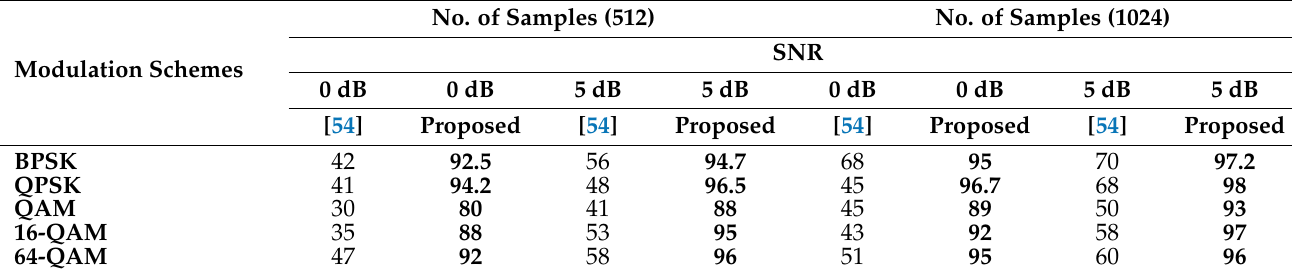
Table 7. PRA comparison on the Rayleigh channel